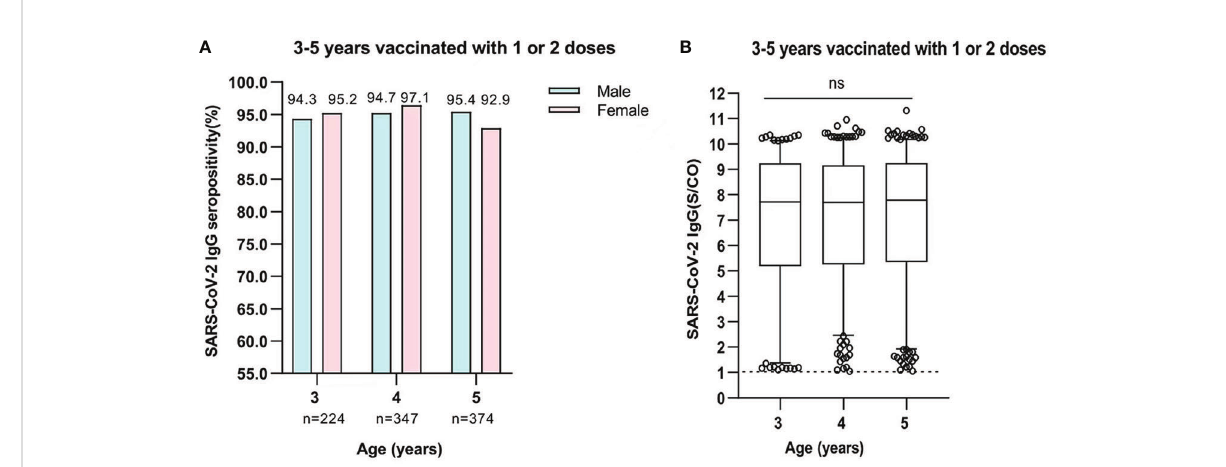
FIGURE 4 (A) Comparison of SARS-CoV-2 IgG seropositivity between male and female participants who were aged 3-5 years and were vaccinated with one or two doses. Data was expressed as percentage, and analyzed using the Chi-square test. The SARS-CoV-2 IgG seropositivity in each age showed no signi fi cant difference between male and female participants. (3 years, c 2 = 0.075, P=0.784; 4 years, c 2 = 1.52, P=0.263; 5 years, c 2 = 1.097, P=0.295). (B) The levels of SARS-CoV-2 IgG antibody in participants who were aged 3-5 years and were vaccinated with one or two doses. Data was expressed as median (interquartile range), and analyzed using the Mann ‐ Whitney U test. The midlines represent median values, and the boxes represent interquartile ranges [3 years, 7.712 (IQR, 5.189-9.245); 4 years, 7.694 (IQR, 2.252-9.163); 5 years, 7.780 (IQR, 5.350- 9.255)]. The positive levels of SARS-CoV-2 IgG antibody showed no signi fi cant difference among participants(P=0.4717). ns, not signi fi